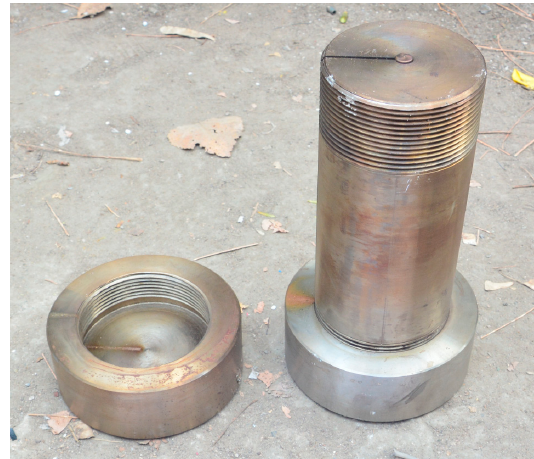
Figure 3. Cook-off bomb after tests.